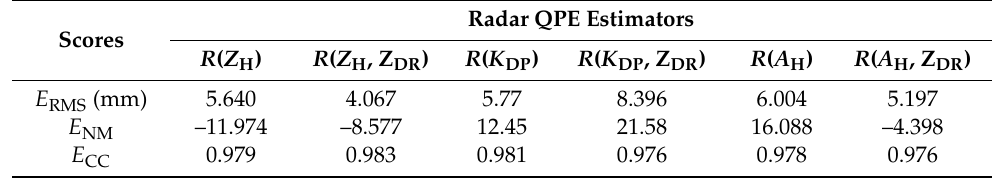
Table 1. Evaluation scores of the 3-h rainfall estimates from the CPOL